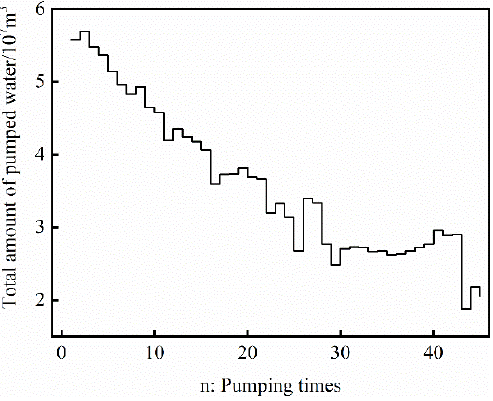
Figure 16. The maximum amount of water pumping under different pumping times. Table 7. Optimization scheme of single well pumping.